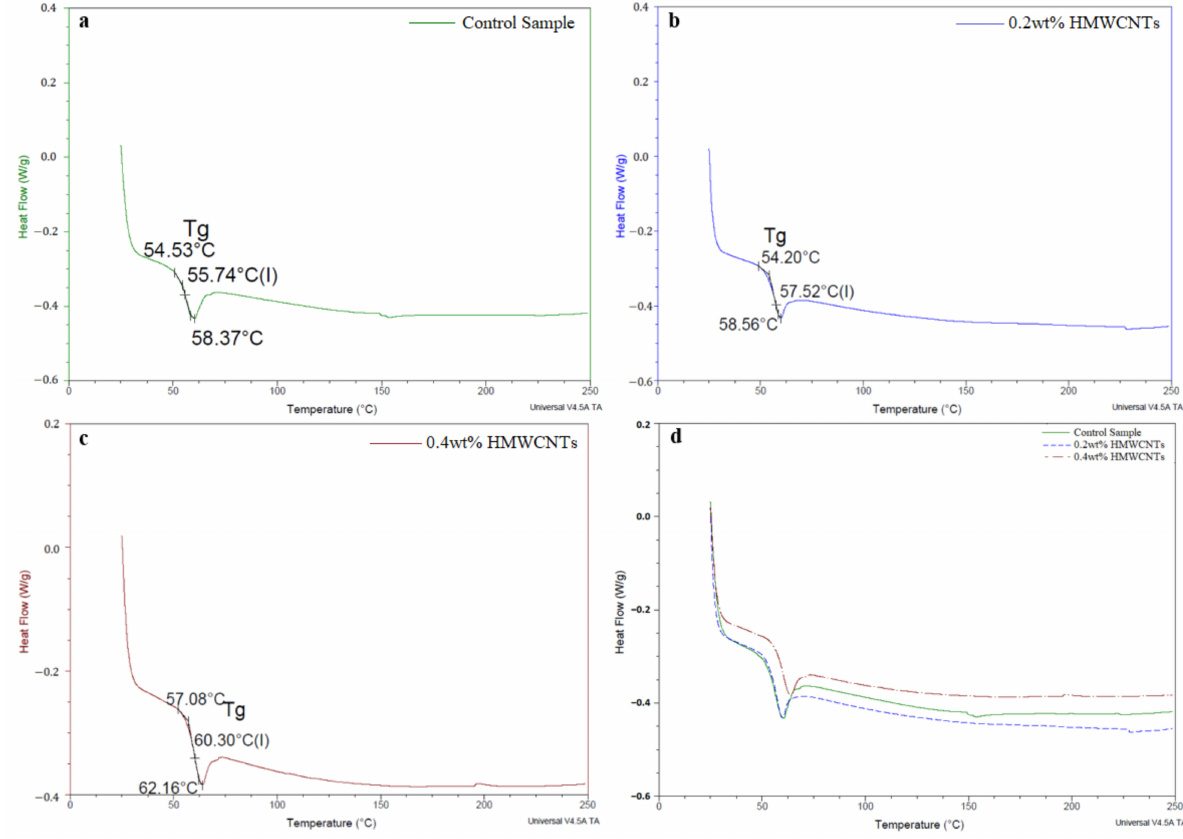
Figure 12. DSC analysis of the ( a ) control sample, the ( b ) 0.2 wt.% HMWCNT, the ( c ) 0.4 wt.% HMWCNT, and a ( d ) compar- ison of all of the